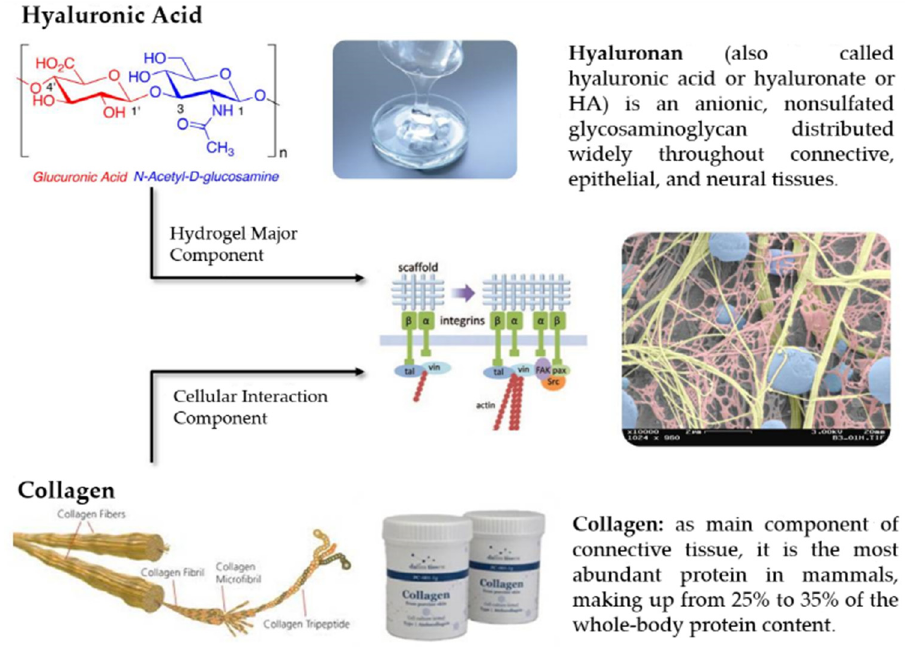
Figure 2. Hyaluronic acid and collagen are two of the most extensively studied and frequently used forms of naturally derived biomaterials in tissue engineering.